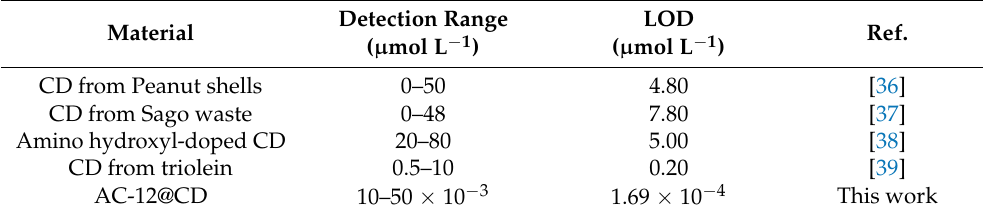
Table 5. Comparison of a few reported materials for fluorescence detection of Cu 2+